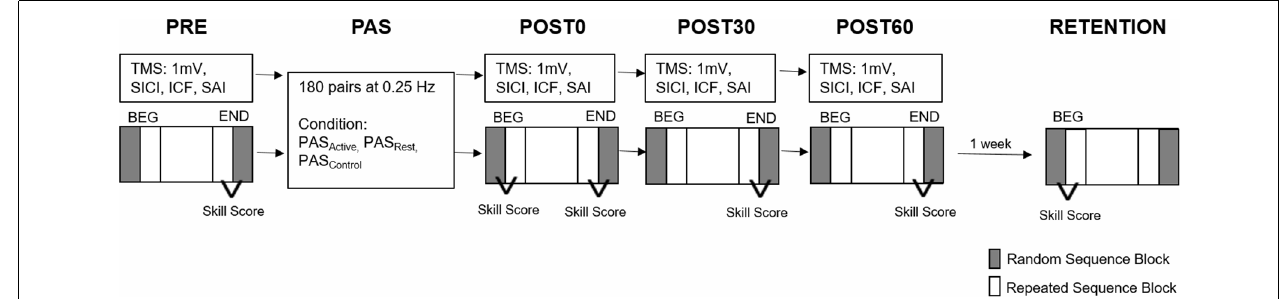
FIGURE 1 | Experimental paired associative stimulation (PAS) paradigm. Each PAS protocol consisted of 180 pulse pairs using an interstimulus interval of N20 + 5 ms at 0.25 Hz delivered over the median nerve and primary motor cortex (M1). Measures of corticomotor excitability (1 mV, SICI, ICF, SAI) and motor behavior were assessed at baseline (PRE), immediately following PAS (POST 0) and at 30 and 60 min following PAS (POST30 an POST60). Motor behavior was also reassessed at a RETENTION time point approximately 1 week following POST60 in a subset of individuals. Skill Score was calculated as the difference between the random sequence block (gray) and repeated sequence block (white) at the BEG or END of each testing time point (SICI, short interval cortical inhibition; ICF, intracortical facilitation; SAI, short afferent inhibition; BEG, Beginning block; END, End